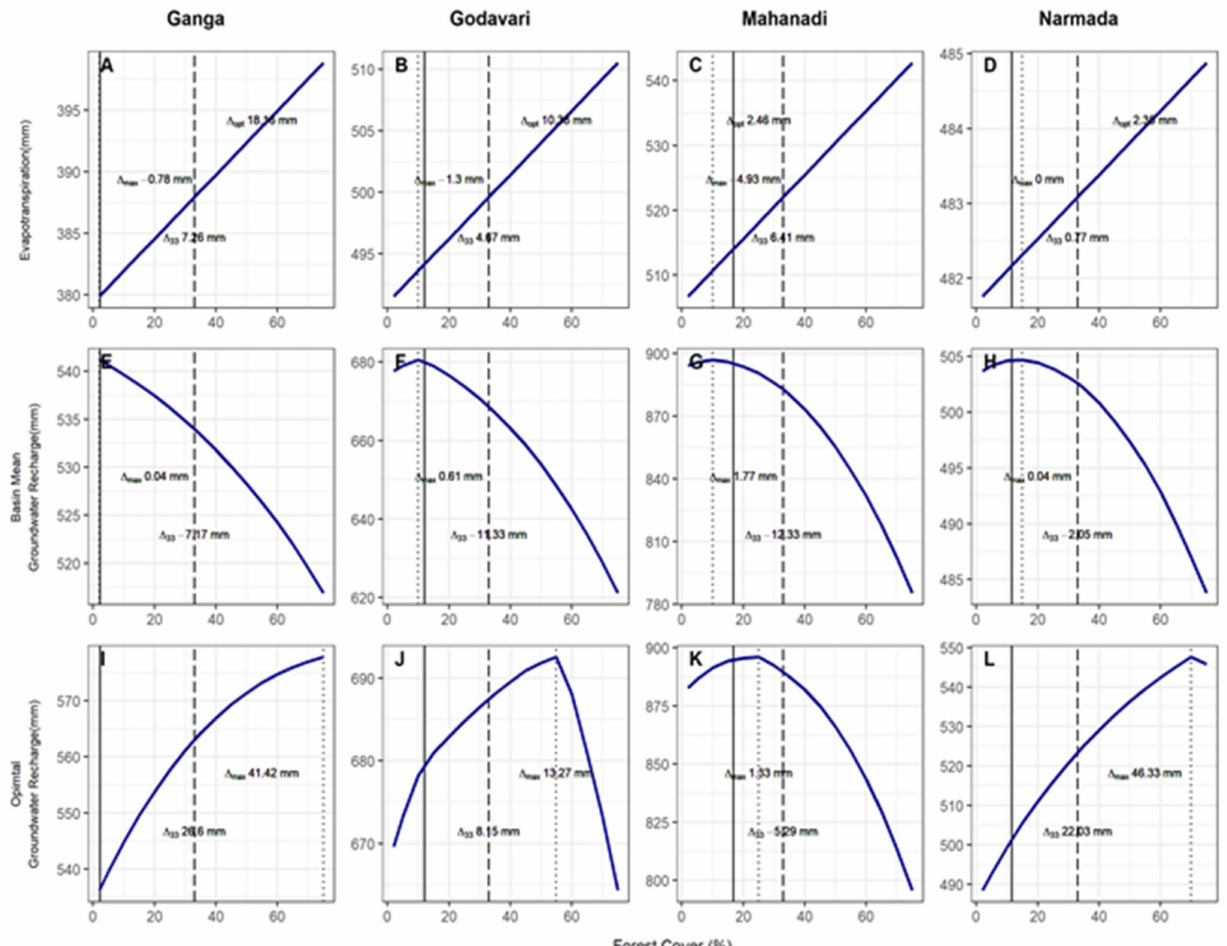
Figure 6. Basin hydrological flux changes over the range of forest cover from 2% to 75%. Evapotranspiration ( A – D ) shows a linear increase as forest cover increases. The basin mean pathway to increase forest cover ( E – H ) shows a complex curved relationship of groundwater recharge with increase forest cover. All basins have maximum groundwater recharge near to the current forest cover. Graphs ( I – L ) show groundwater recharge for the groundwater recharge optimized pathway. The optimized pathway demonstrates that it is possible to achieve increases to groundwater recharge with increased forest cover at the basin scale depending on the land converted to